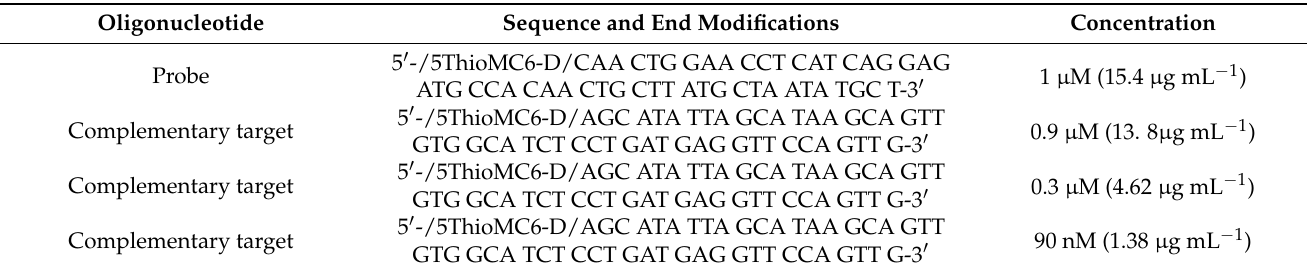
Table 2. Complementary sequences used to measure the sensitivity of the microcantilever sensors.